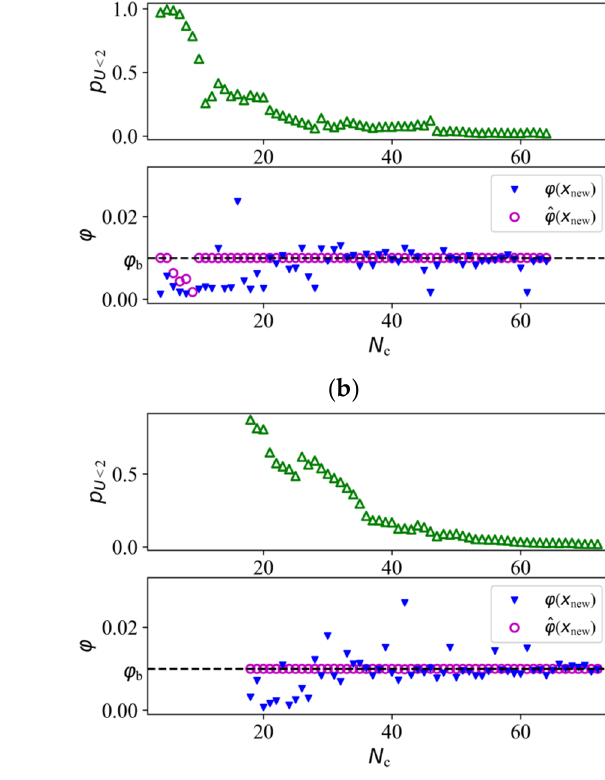
Figure 5. Candidate points.